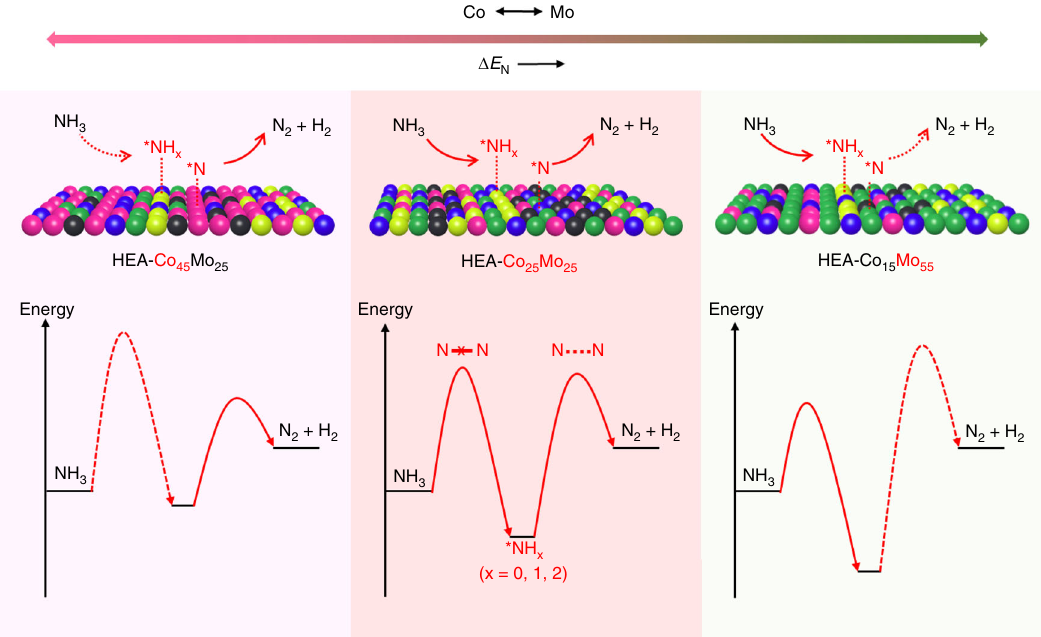
Fig. 6 Schematic illustration of the rate-limiting factors in NH 3 decomposition. The rate-limiting factors are labeled with dash lines in the lower panel. On Co-rich surface (left), the rate is limited by activation or dehydrogenation of NH 3 ; on Mo-rich surface, the rate is limited by the recombinative desorption of *N; Balance for these two steps is reached on an intermediate composition (HEA-Co 25 Mo 45 )